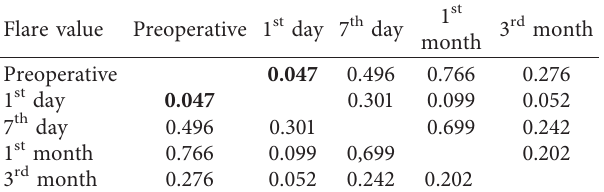
The bold values represent p <